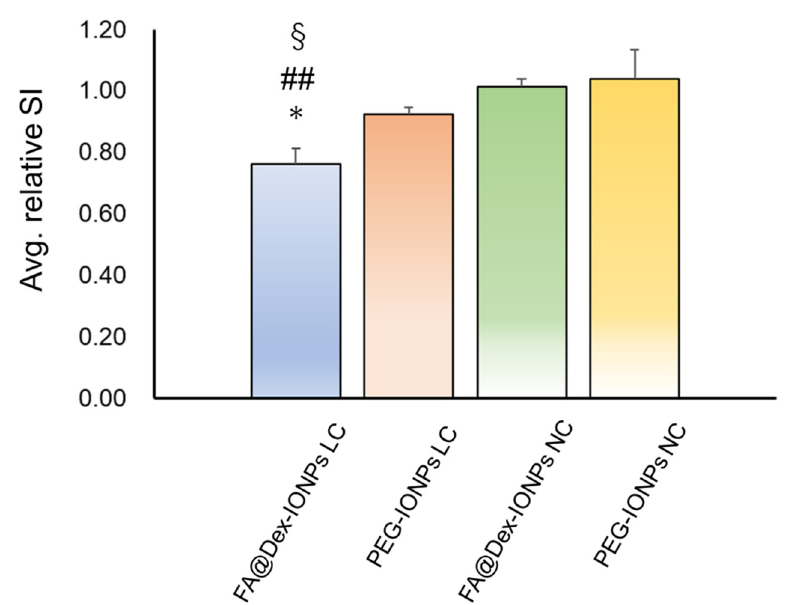
Figure 4. Comparison of the averaged relative signal intensity (avg. relative SI) of FA@Dex-IONPs LC, PEG-IONPs LC, FA@Dex-IONPs NC, and PEG-IONPs NC mice 24 h after administration, which were evaluated for ROIs LC_cancer and ROIs NC . Significant differences between groups are indicated by symbols (*: p < 0.05 between FA@Dex-IONPs LC and PEG-IONPs LC, ##: p < 0.01 between FA@Dex-IONPs LC and FA@Dex-IONPs NC, §: p < 0.01 between FA@Dex-IONPs LC and PEG-IONPs